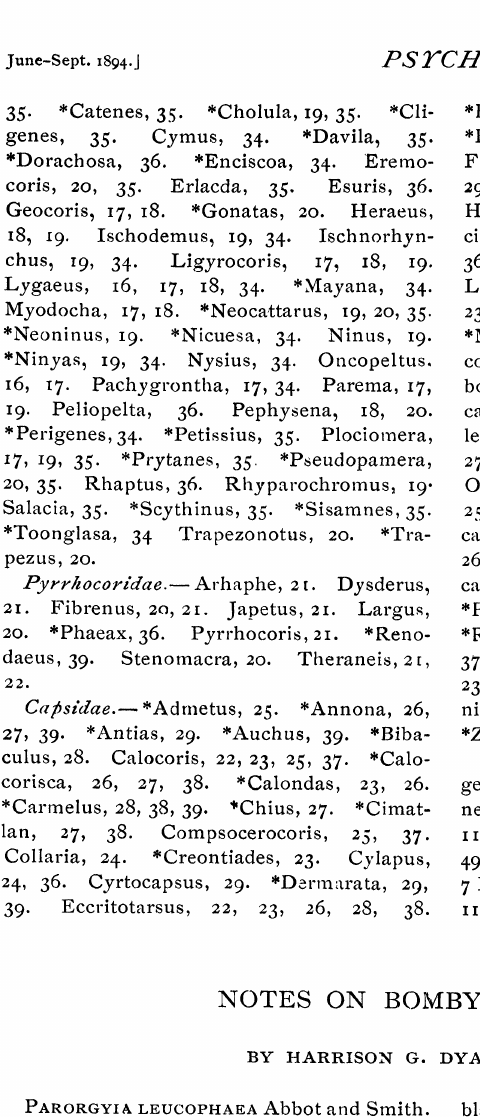
black.; a black dorsal line, interrupted on the summits of the posterior segments. Long silky white hairs, with a few black ones arise from the subventral warts. The lateral row (row iii) furnishes shorter bristly yellowish hairs; but on joints 2 and 3 gives a long pencil of black hairs. A few black hairs also overhang the head and extend from joint